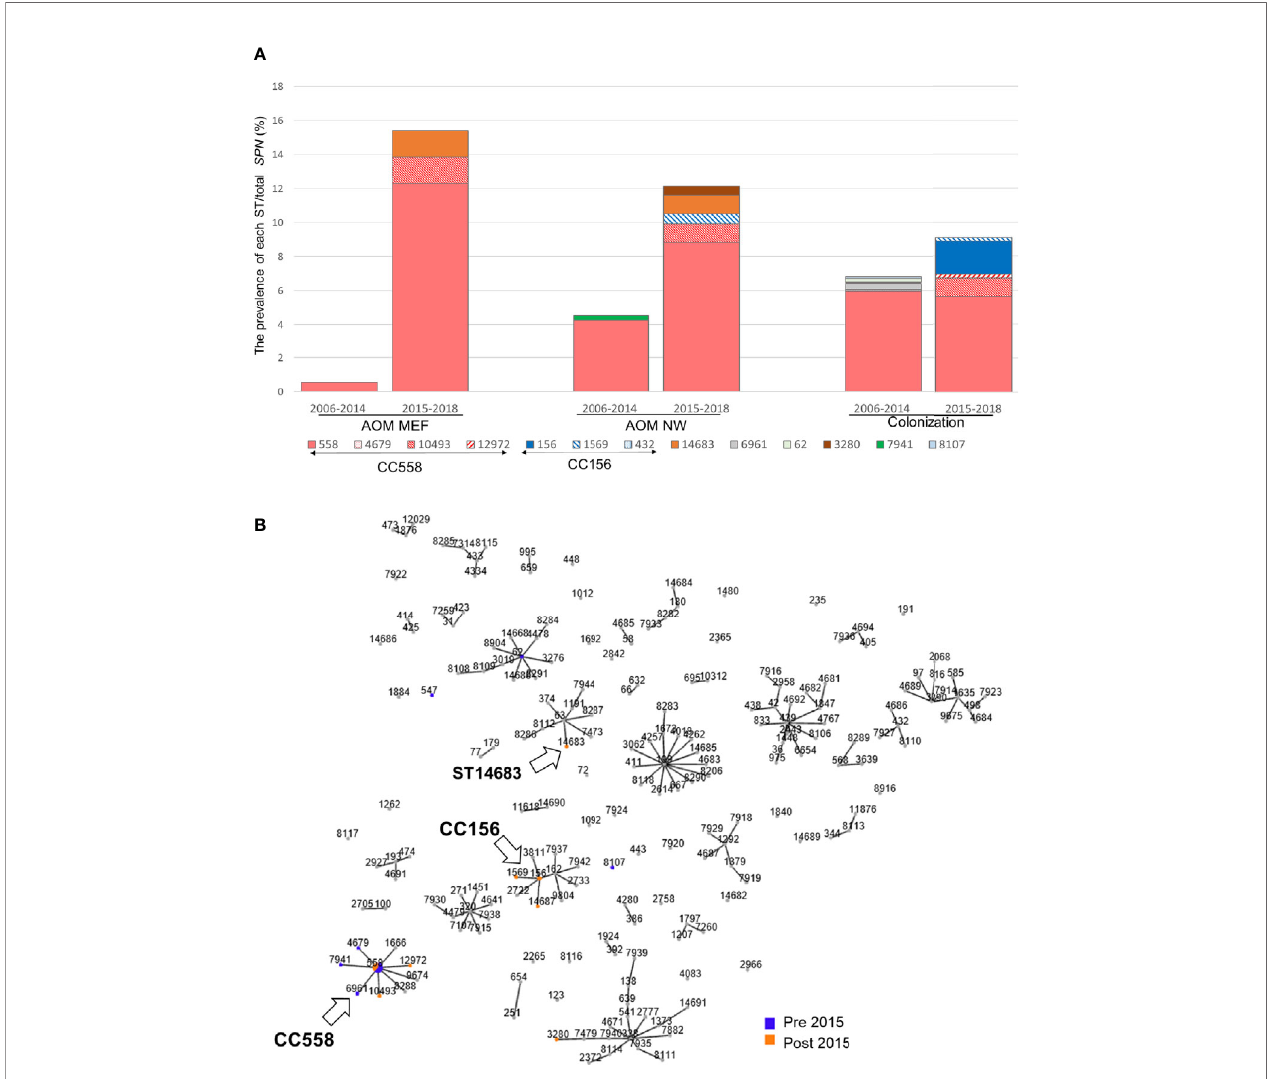
FIGURE 2 | (A) Sequence type distribution and prevalence/total S. pneumoniae isolates between pre-2015 and post-2015. The prevalence (%) of each ST was calculated by dividing the number isolates with the total number of SPN isolates between 2006 – 2014 and 2015 – 2018. (B) All MLST types and their association with serotype 35B from strains isolated during 2006 – 2019 in Rochester, NY. Clonal complex that shared greater than fi ve out of seven MLST alleles was linked. Arrow marked 35B/CC558, 35B/CC156, and